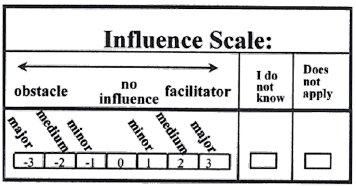
Figure 8. The influence scale: the impact of social and physical